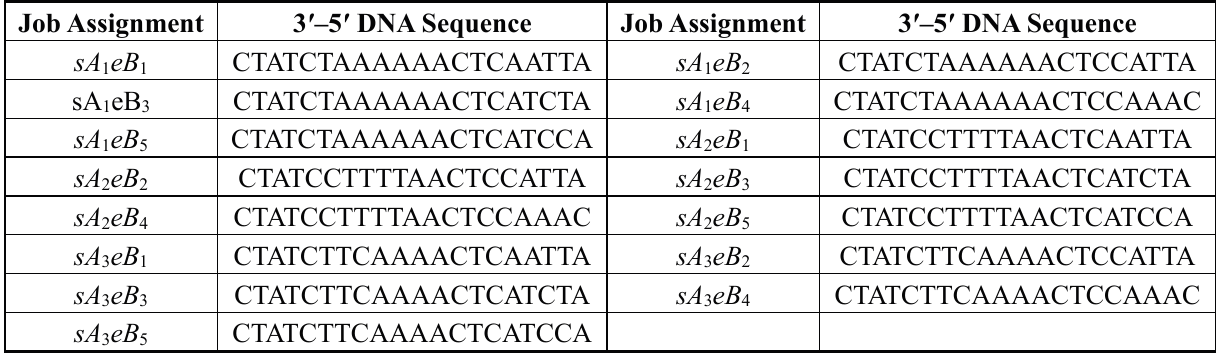
Table 9. Sequences chosen to represent the job assignment schemes sA i eB j (1 ≤ i ≤ m , 1 ≤ j ≤ n ) in the example for Table 1.